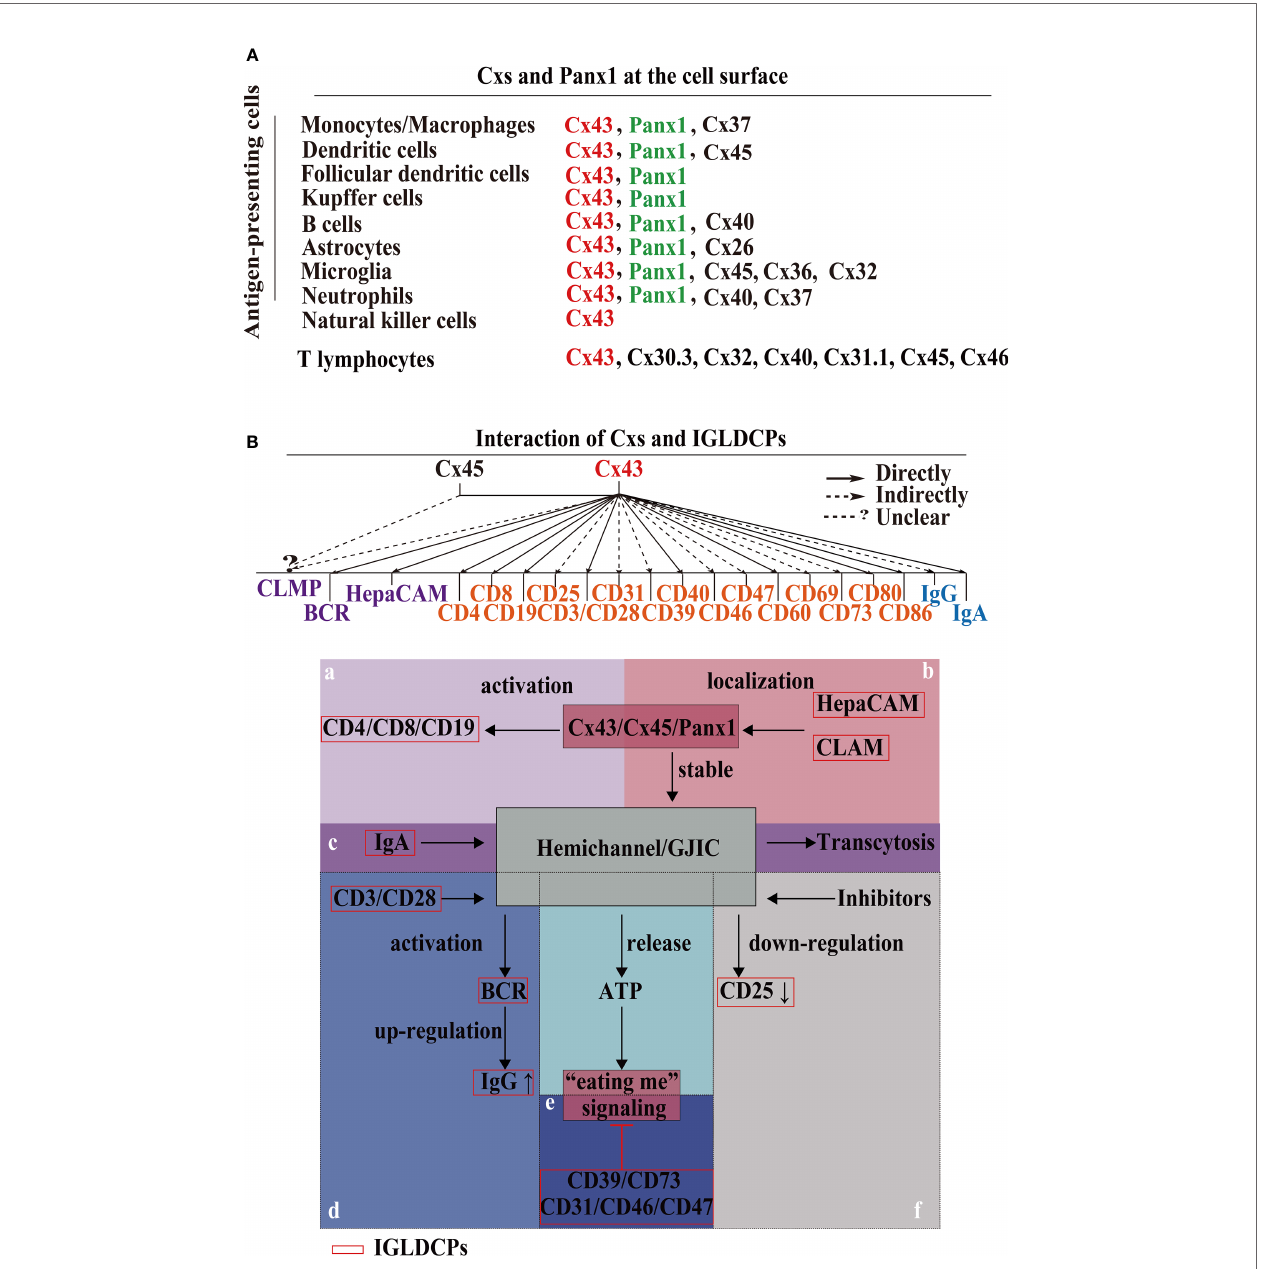
FIGURE 1 | Cxs and Panx1 on the immunological cell surface and their mutual interaction with IGLDCPs. (A) Cxs and Panx1 localize at the cell surface. Cxs and Panx1 HCs have been identi fi ed in nine types of APCs and T lymphocytes, primarily for the signaling role of HCs with IGLDCPs in the innate – adaptive immune response (17, 18). (B) The mutual interaction of HCs and IGLDCPs. Cx43, which interacts with at least 20 IGLDCPs: a The activation of CD4/CD8/CD19 requires Cx43/HC (19 – 21). b HepaCAM and CLAM facilitates Cx43 membrane localization and GJIC establishment (22 – 24). c GJIC mediates the transcytosis of IgA in CD19 + B cells (21). d CD3/CD28/CD40 activate BCR signaling and upregulate IgG expression by Cx43/HC opening (25). e The “ eating me ” signaling pathway is inhibited by CD39/CD73/CD31/CD46/CD47 (14, 26). f CD25/69 are downregulated by the inhibition of Cx43/HC (3). Cxs, connexins; Panx, pannexin; IGLDCP, Ig- like domain-containing protein; HC, hemichannel; APC, antigen-presenting